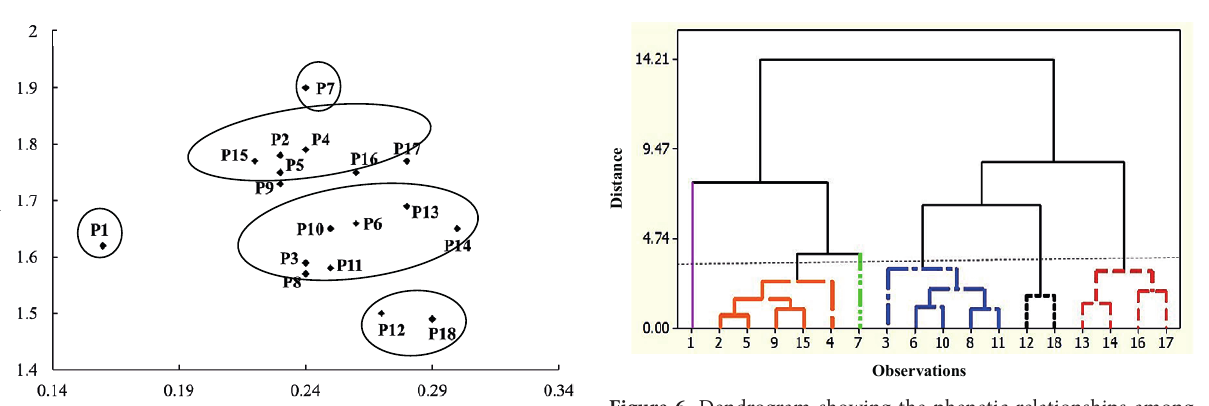
Figure 6. Dendrogram showing the phenetic relationships among the studied populations of Ferula assa-foetida L. populations. Table 4. Mean (± Se) comparisons of monoploid genome size